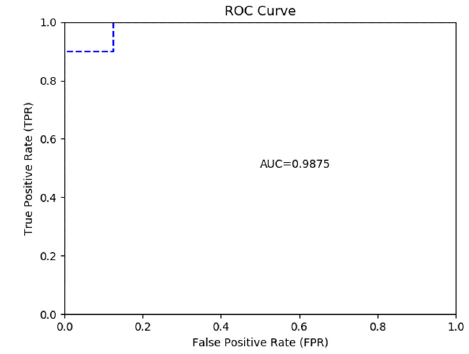
Figure 6. ROC curve for w ‐ HHH filter classification.